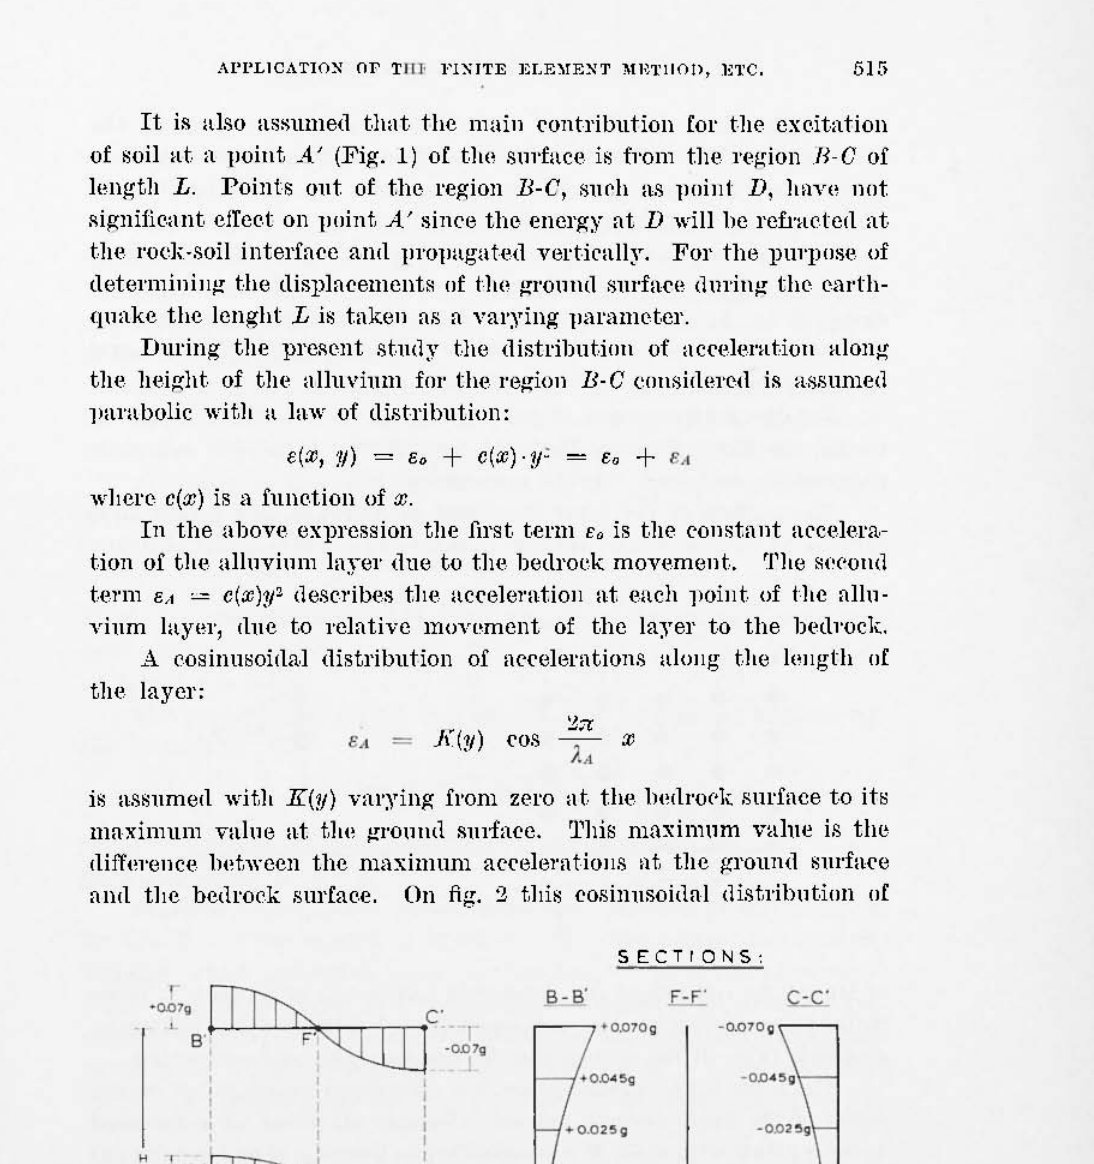
On fig. :2 this cosinusoitlnl distl'ibut.ion of